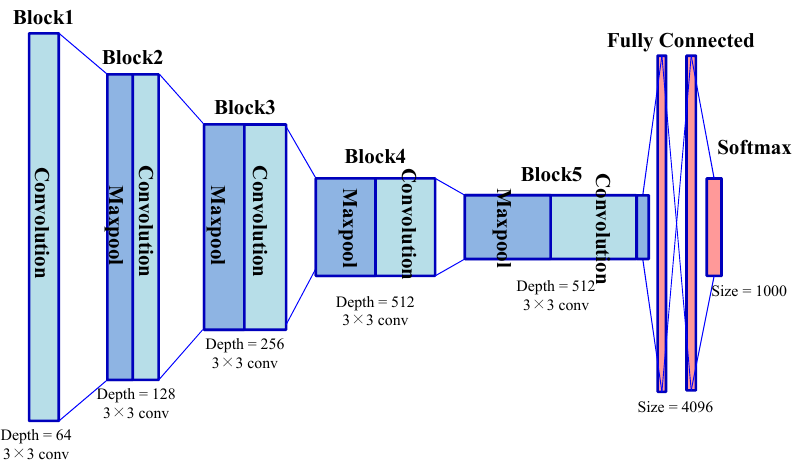
Figure 9. The structure of VGG19 (Visual Geomtry Group, Number 19).